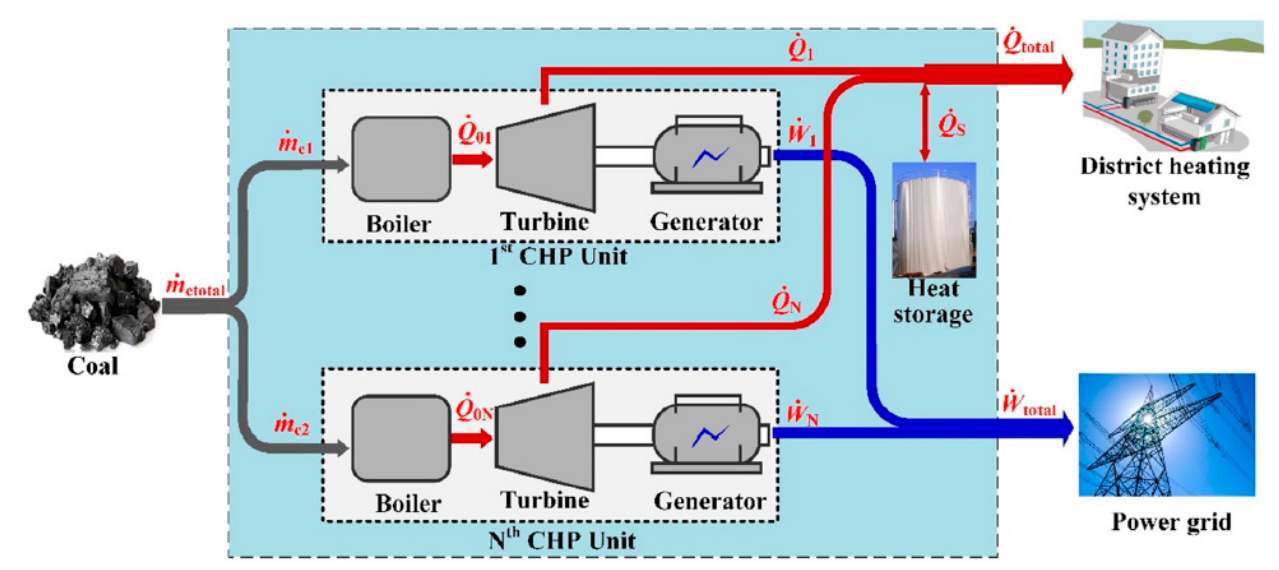
Figure 4. Configuration of a large-scale CHP plant composed of two CHP units and a thermal stor- age tank